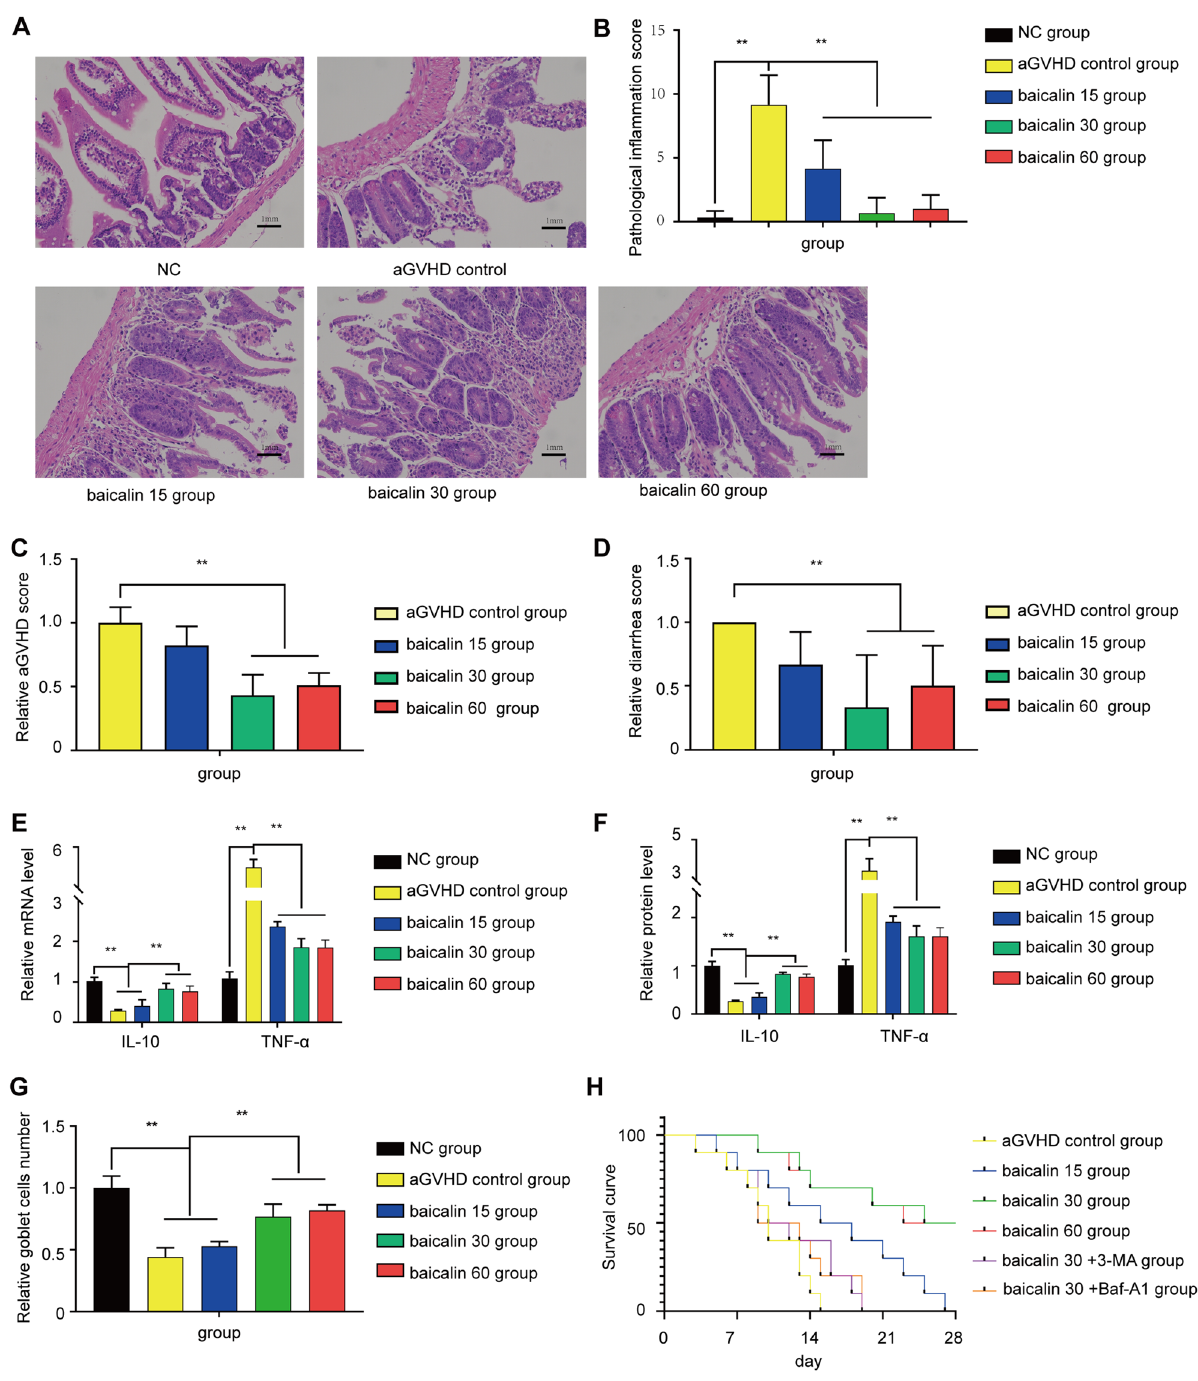
Figure 1. Mouse survival curve and small intestinal pathology. There were 6 mice in the normal control group, and the other groups had 10 mice in each group. ( A ) Representative intestinal histology from each experimental group on the 15th day (H&E staining, 200 ×). ( B ) Analysis of the mouse small intestine pathological scoreon the 15th day. ( C ) Clinical aGVHD score of each experimental group on the 15th day. ( D ) Diarrhea score of each group on the 15th day. € mRNA Levels of the inflammatory factors IL-10 and TNF-α in the experimental group on the 15th day. ( F ) Protein levels of the inflammatory factors IL-10 and TNF-α in the experimental group on the 15th day. ( G ) Goblet cell number in different groups on the 15th day. ( H ) Survival curve of mice of the experimental groups of mice. The data are presented as the mean ± SD. Every experiment was repeated in triplicate. ** P < 0.01 compared with the aGVHD control